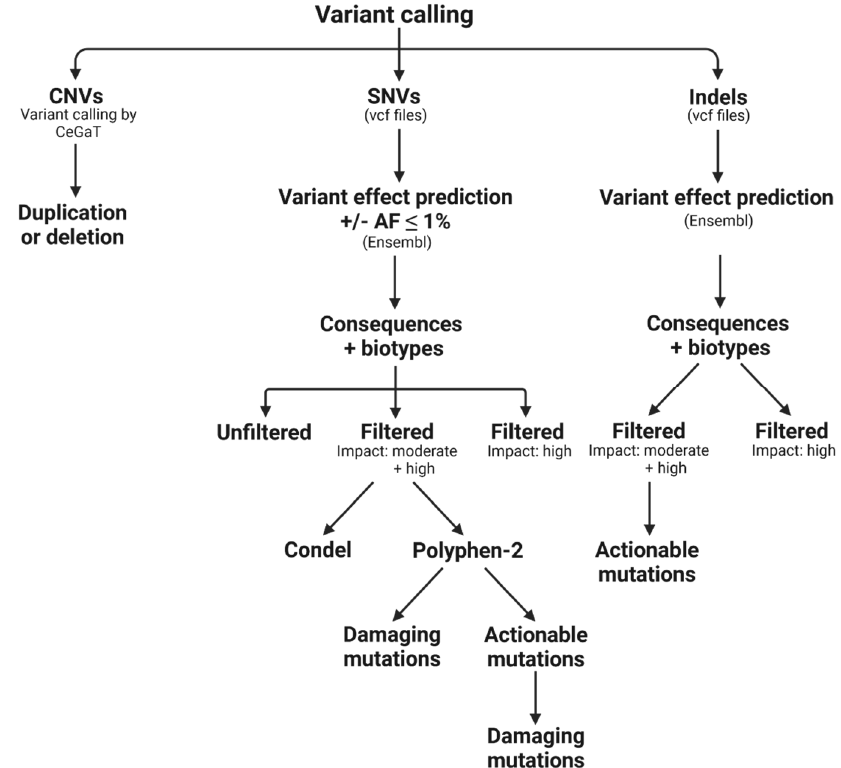
Figure 2. Collected data were processed by variant calling/variant effect prediction (Ensembl) of vcf-files for detected indels and SNVs, and resulting data were analyzed for biotypes, consequences, impact, damaging/severity scores PP-2 and Condel and actionable variants (suggested by COSMIC database). Called CNVs were analyzed for duplications or deletions.